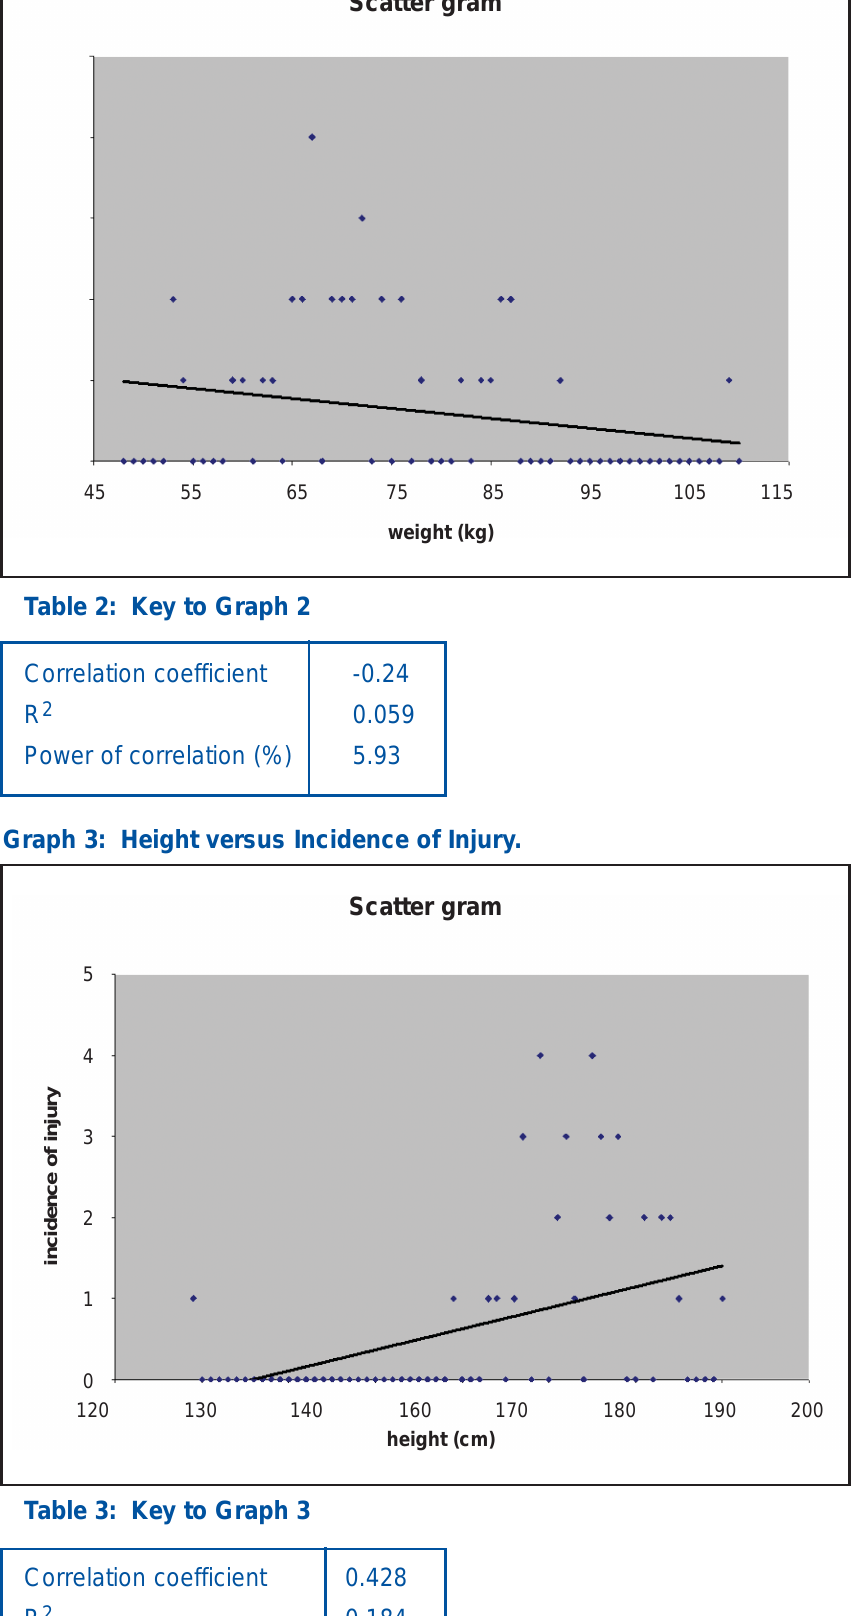
Table 3: Key to Graph 3 Correlation